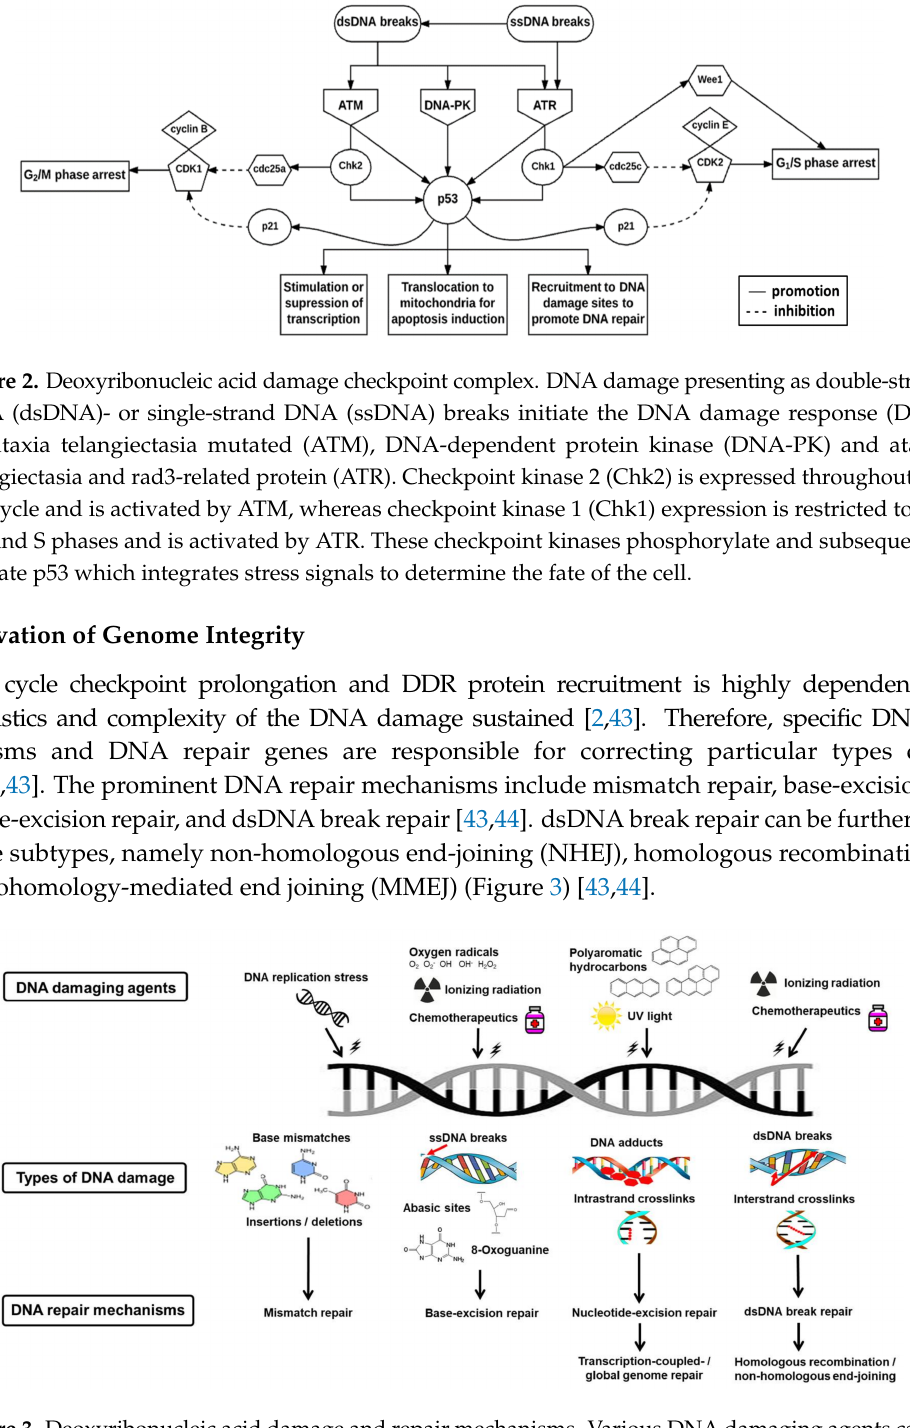
Figure 3. Deoxyribonucleic acid damage and repair mechanisms. Various DNA damaging agents cause a range of DNA lesions. Each are corrected by a specific DNA repair mechanism, namely mismatch repair, base-excision repair, transcription-coupled/global genome repair, or homologous recombination (HR)/non-homologous end-joining